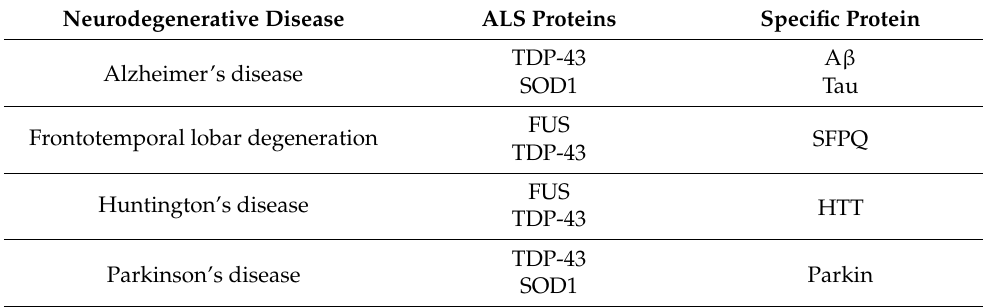
Table 1. ALS proteins also found in other neurological